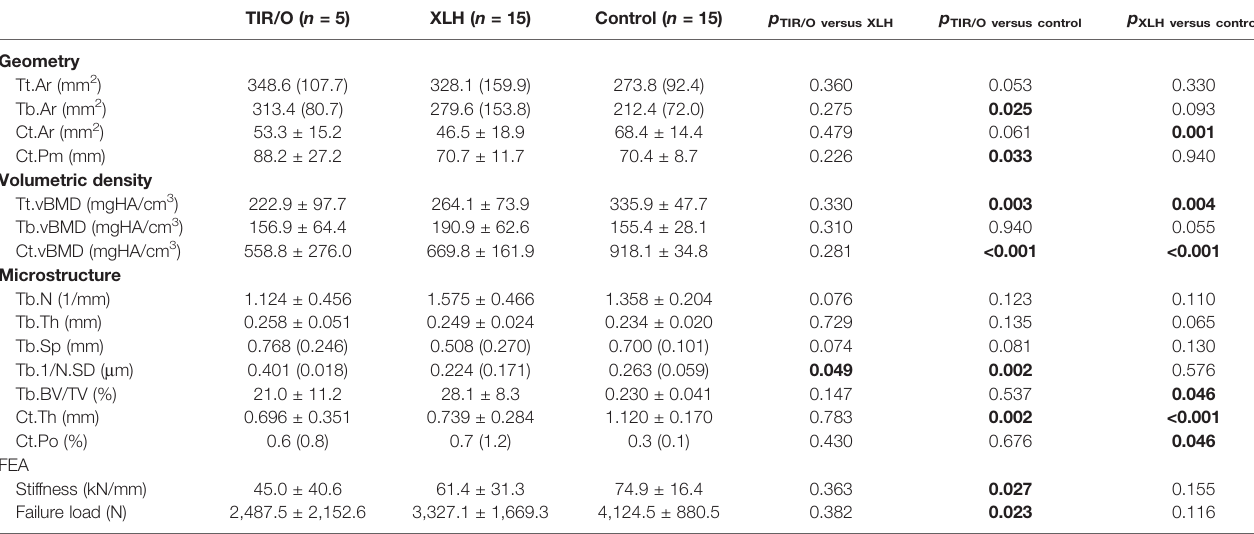
TABLE 2 | Comparison of HR-pQCT measurements and estimated bone strength at the distal radius. TIR/O ( n = 5) XLH ( n = 15) Control ( n = 15) p TIR/O versus XLH p TIR/O versus control p XLH versus control Geometry Tt.Ar (mm 2 )